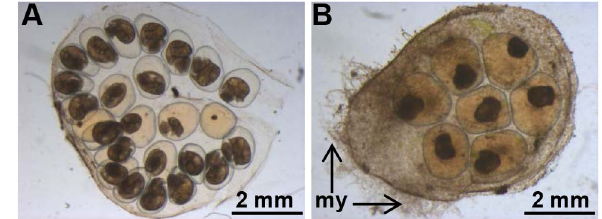
Figure 7. BgLBP/BPI1 is essential to protect eggs from oomycete infection. Typical egg mass from Luc- (A) or BgLBP/BPI1 (B) dsRNA-injected parents, after exposure to S. diclina zoospores. Note the well-developed mycelium (my). Egg masses from (A) and (B) have been laid 19–21 days after dsRNA injection to parents and have been exposed to zoospores at day 22. Observation was made after 8 days exposure to S. diclina zoospores. doi:10.1371/journal.ppat.1003792.g007 PLOS Pathogens |